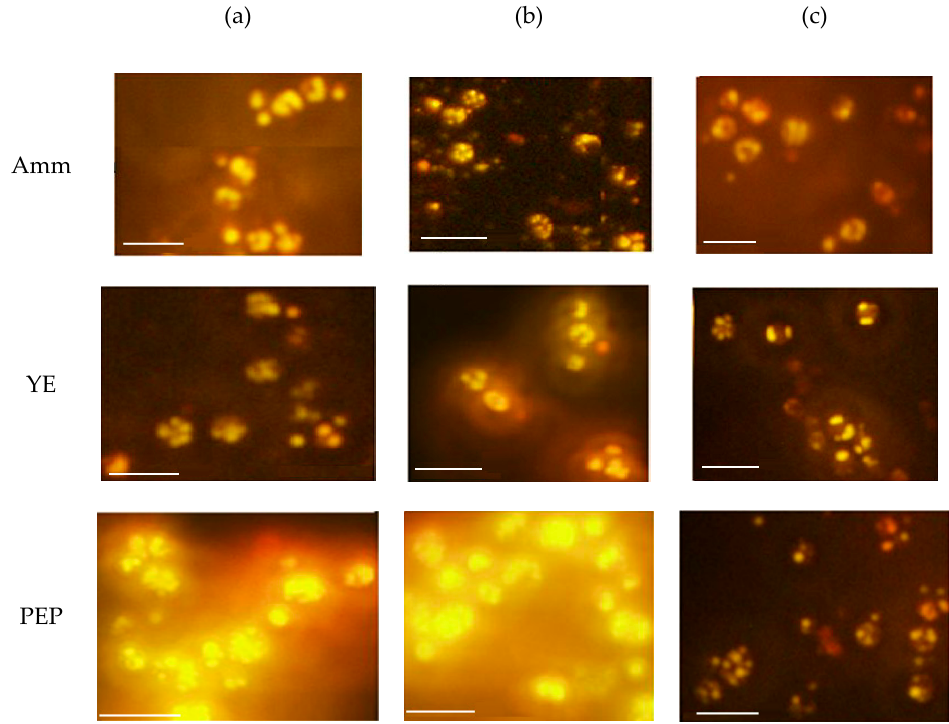
Figure 1. Microscopic examination of yeast cells stained with Nile red fluorescence dye. Yeast cells were grown in different nitrogen sources, Ammonium sulfate (Amm), yeast extract (YE), and peptone (PEP) with different C/N ratios: ( a ) 146, ( b ) 94, and ( c ) 70 for six days. The magnification bar is equal to 10 µm.